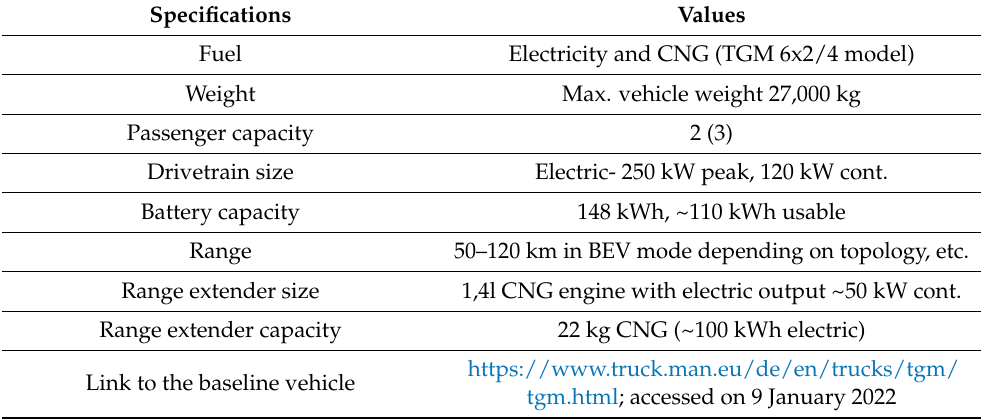
Table 5. MAN refuse collection truck